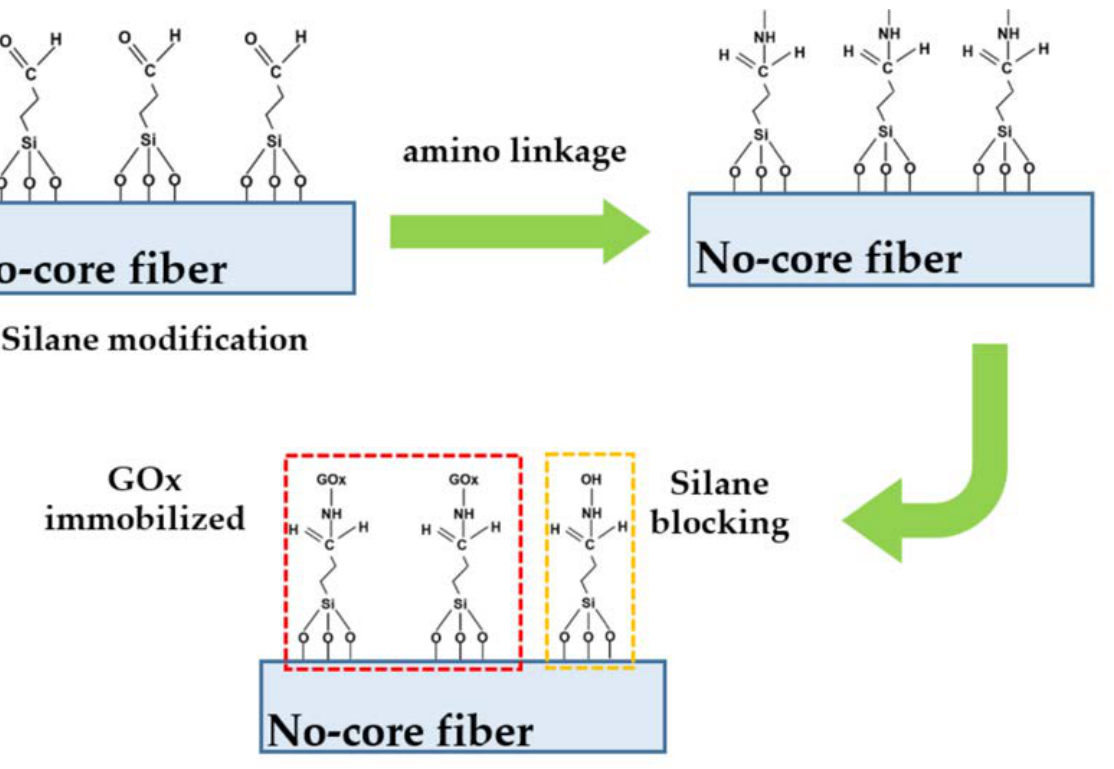
Figure 3. The fabrication procedures of enzymatic no-core fiber sensor.